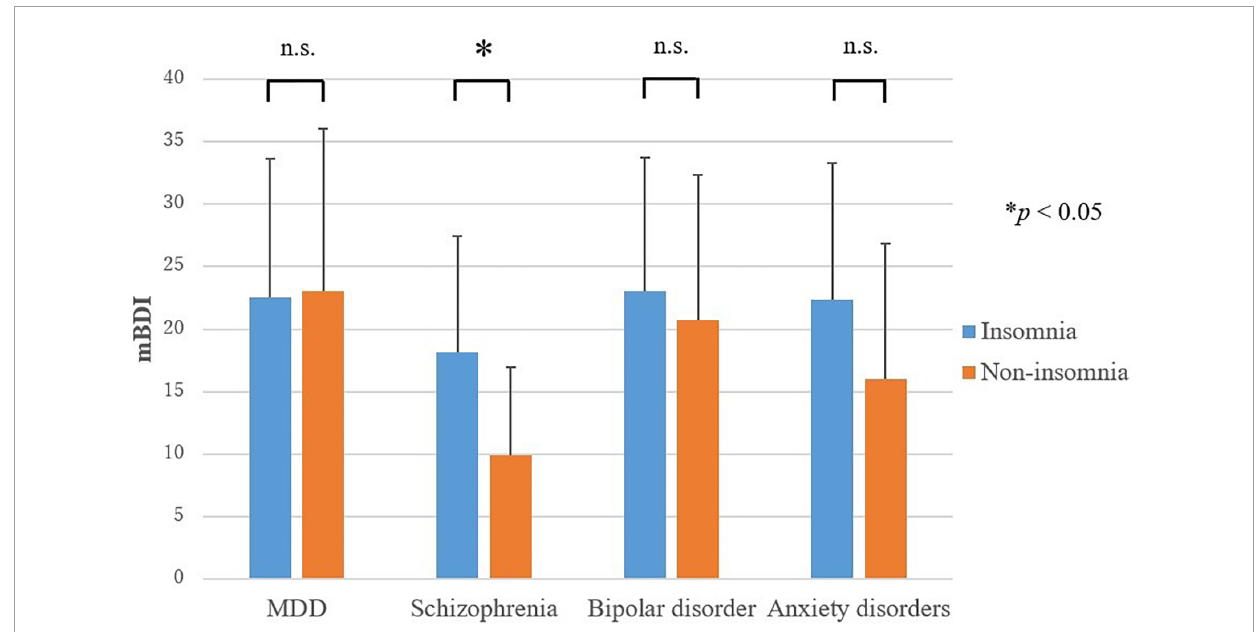
FIGURE2 Severity of depressive symptoms in the insomnia and non-insomnia groups as defined by sleep electroencephalography. MDD, major depressive disorder; mBDI, modified beck depression inventory. Only in schizophrenia, the score for depressive symptoms (mBDI) were higher in the insomnia group than in the non-insomnia group. ∗ P <